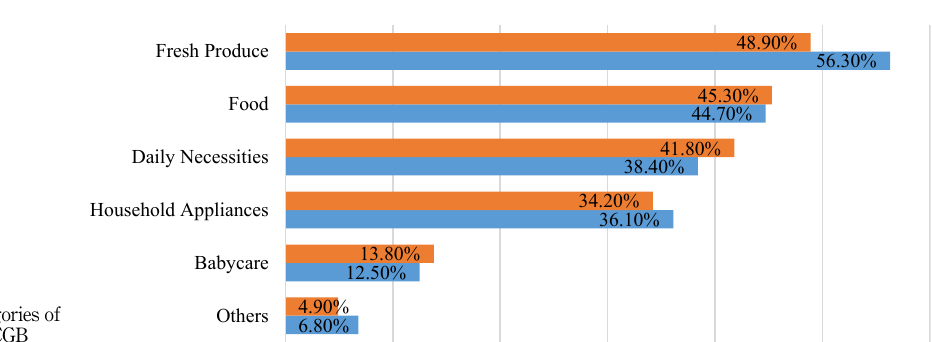
Table 2. Demographic profile of participants